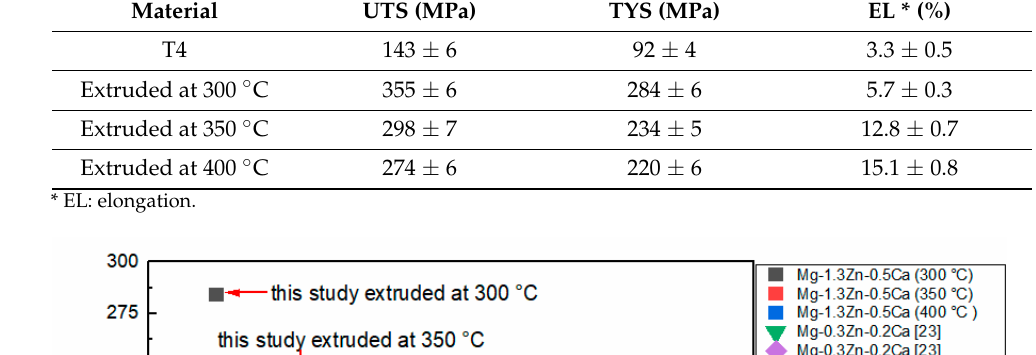
Figure 10. Mechanical properties of the ZX10 alloy extruded at different temperatures. ( a ) the tensile engineering stress- strain curves and ( b ) UTS; ultimate tensile strength, TYS (tensile yield strength), and elongation. Table 1. Results of Tensile Testing of the ZX10 alloy carried out along ED.